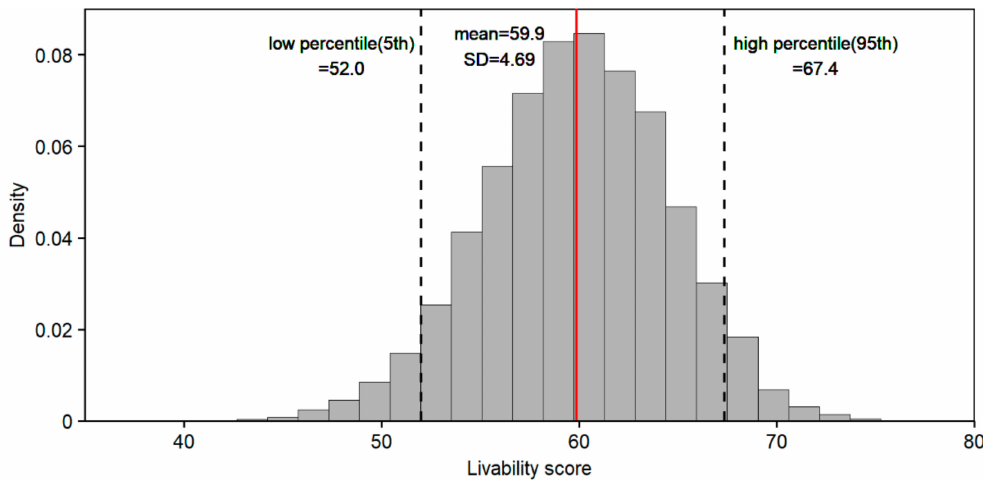
Figure 5. The distribution of livability scores for one community derived from Monte Carlo simulations for 10,000